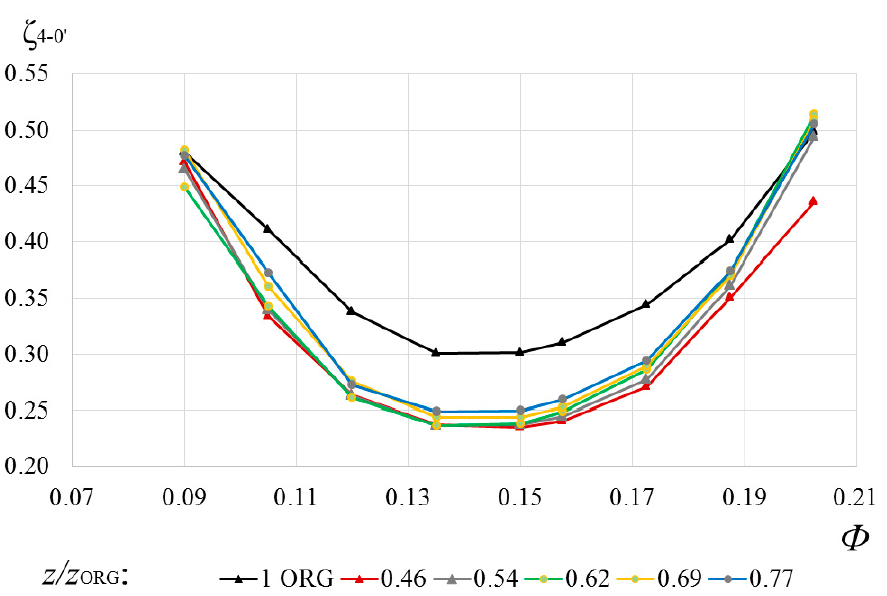
Figure 21. The loss coefficient characteristics of the return channel after preliminary design and of the optimized variants with different numbers of vanes.